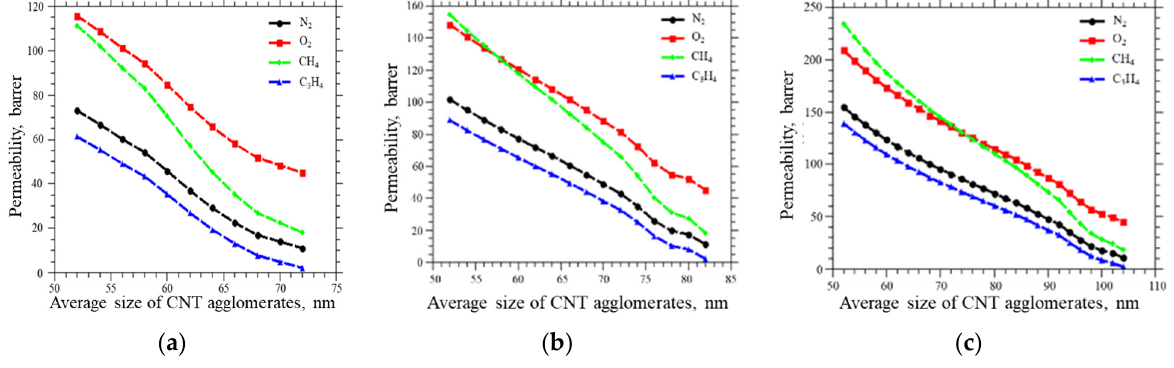
Figure 5. Gas permeability coefficients versus average diameter of CNT agglomerates at a CNTs volume concentration of ( a ) 0.62%, ( b ) 0.82%, and ( c ) 1.24%.